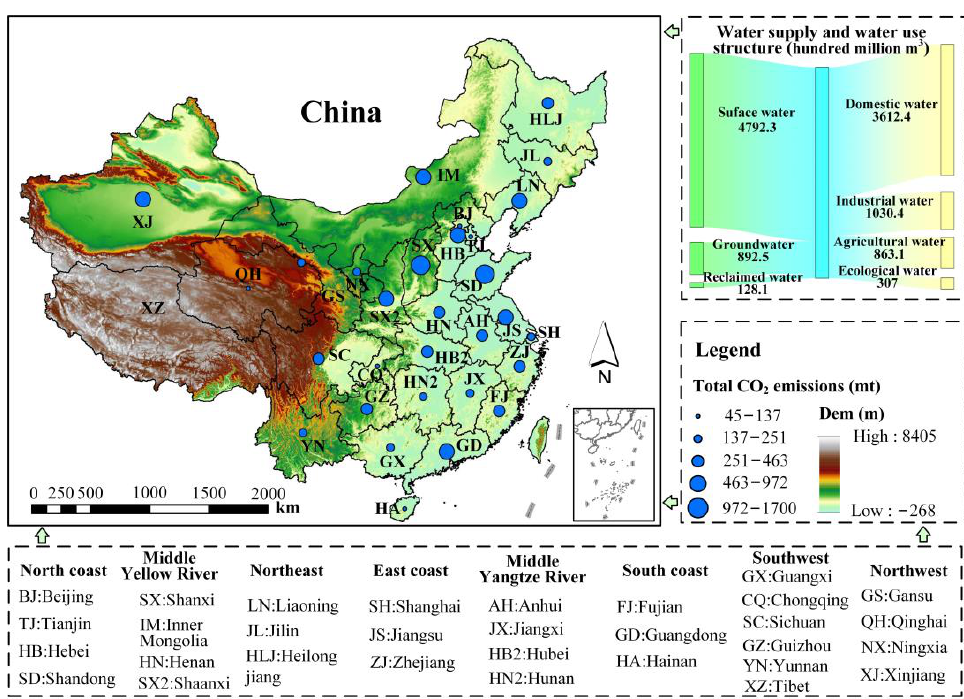
Figure 3. The study area.